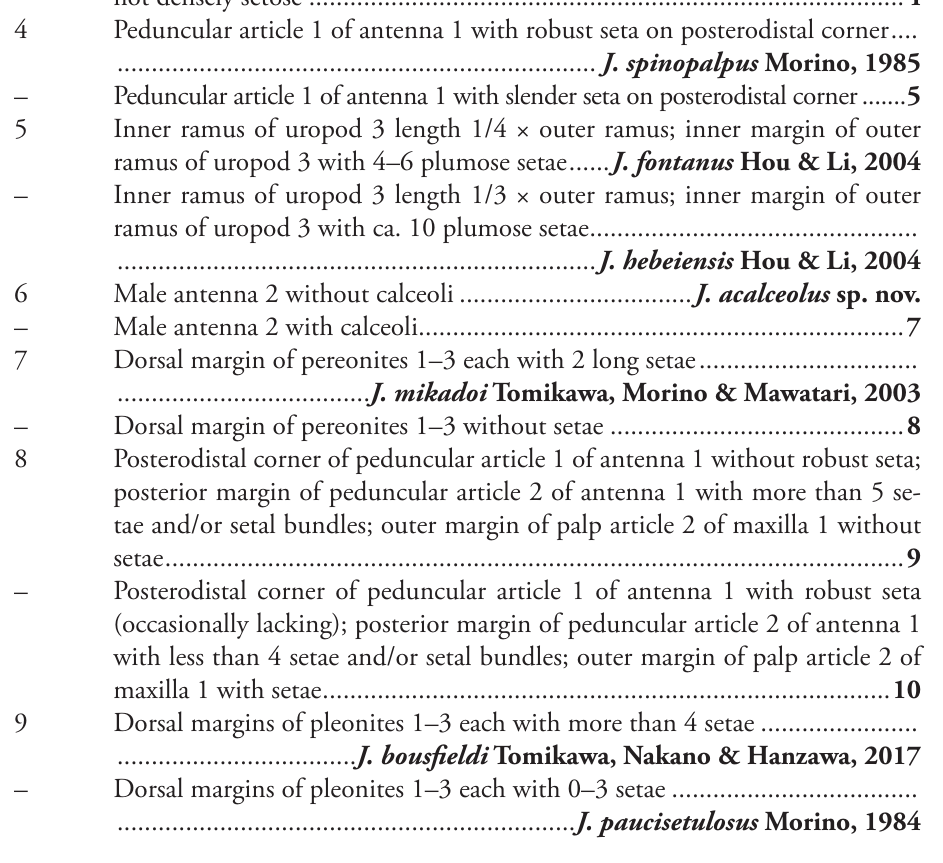
Dorsal margin of pleonites 1–3 each with 1–2 setae; eye large; article 1 of mandibular palp with 1 robust seta; female pereopods densely setose ............ – Dorsal margin of pleonites 1–3 each with more than 4 setae; eye small to me- dium; article 1 of mandibular palp with 2 or 3 robust setae; female pereopods Peduncular article 1 of antenna 1 with robust seta on posterodistal corner ....